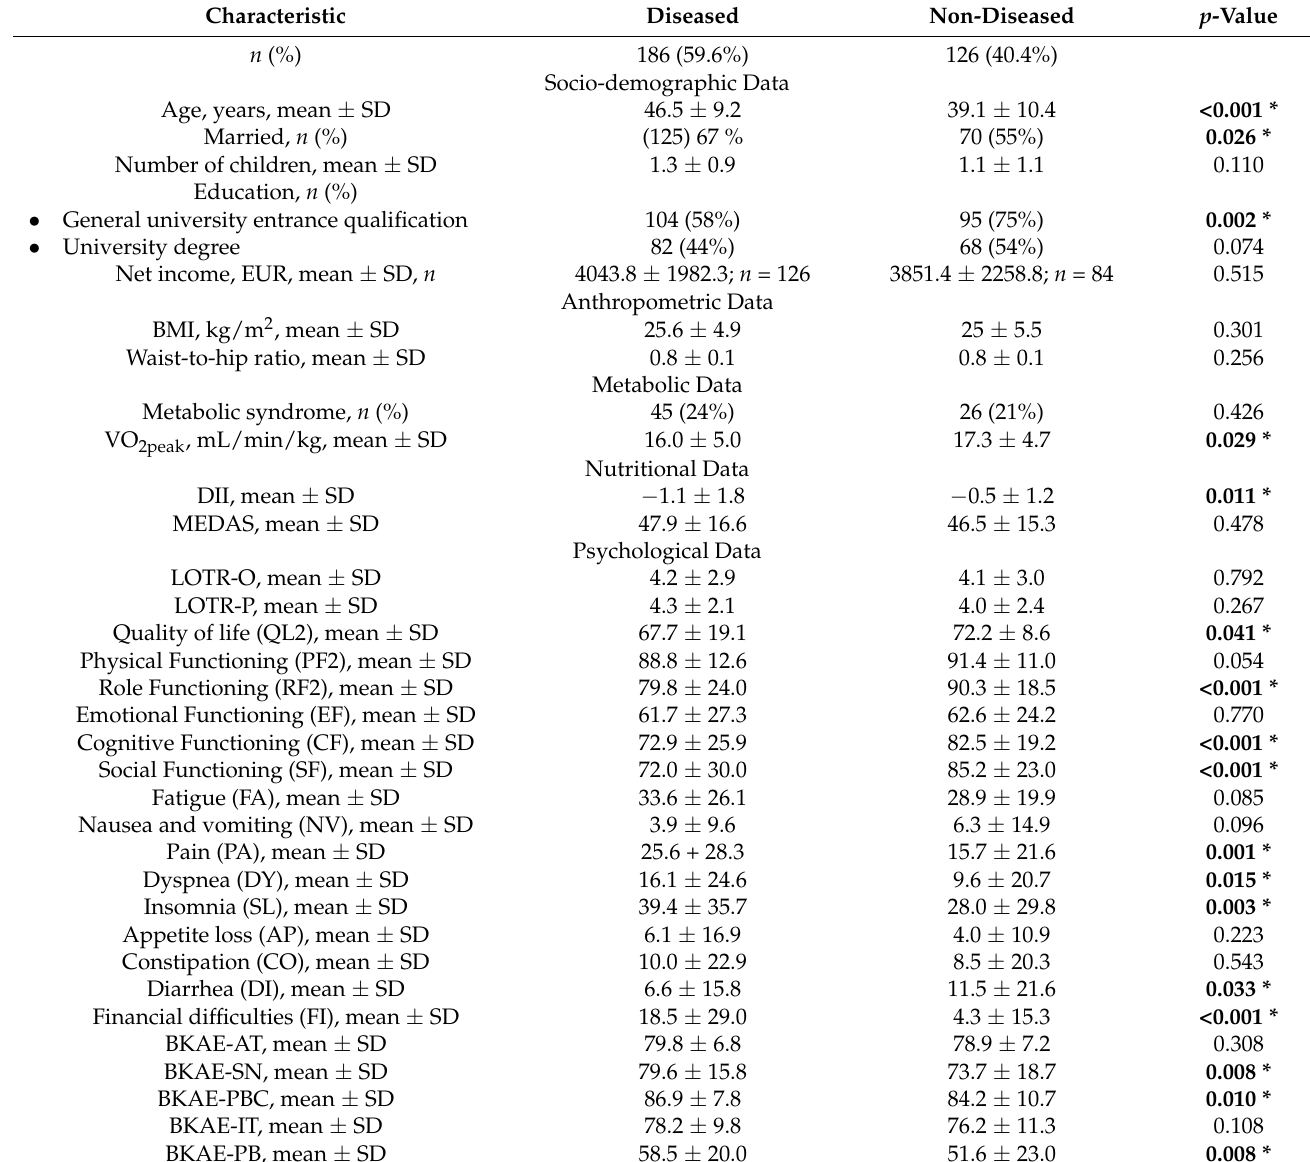
Table 1. Baseline characteristics for participants with and without history of cancer.